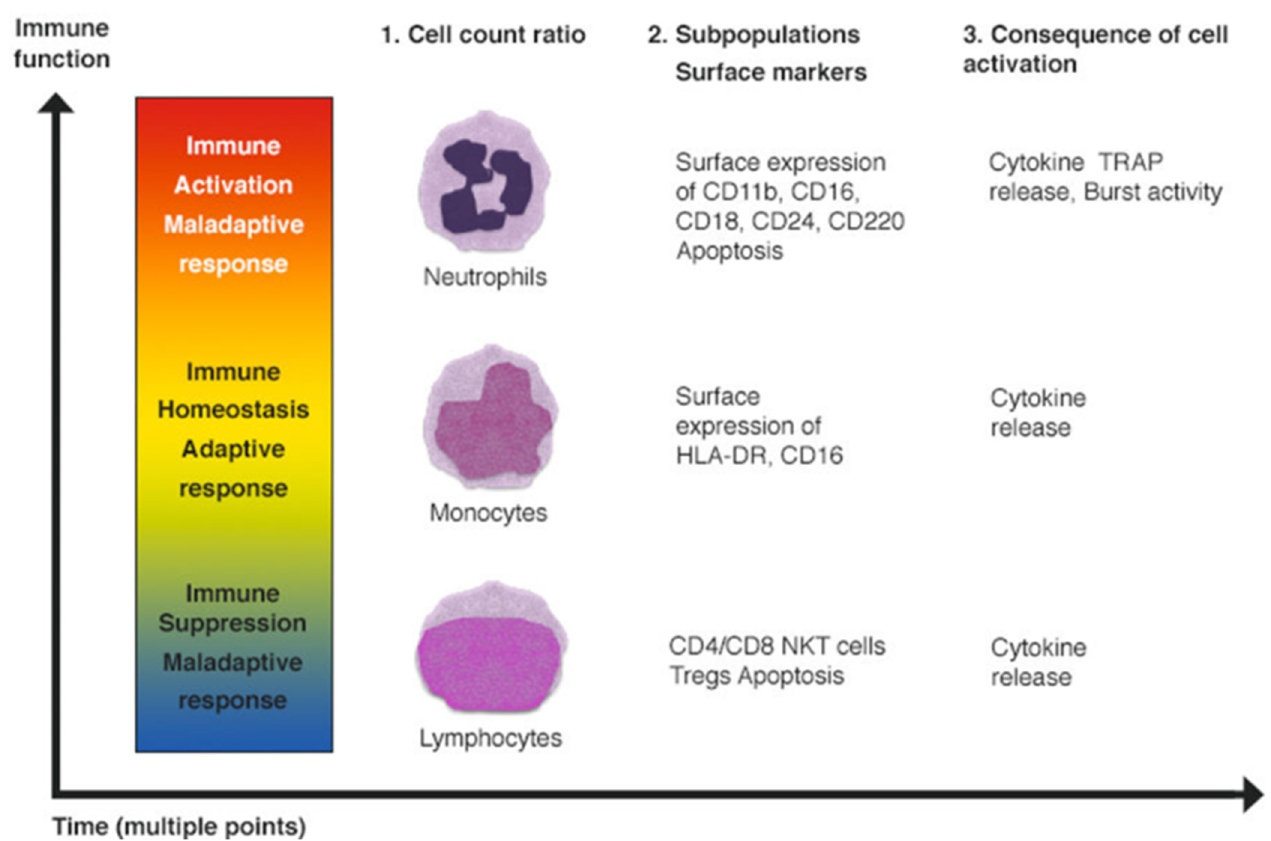
Figure 7. Immune cell activation, suppression and homeostasis. Fluorescence-activated cell sorting (FACS) can identify neutrophils, monocytes and lymphocytes through: (1) cell count ratios; (2) specific subpopulation surface markers; (3) biological changes.